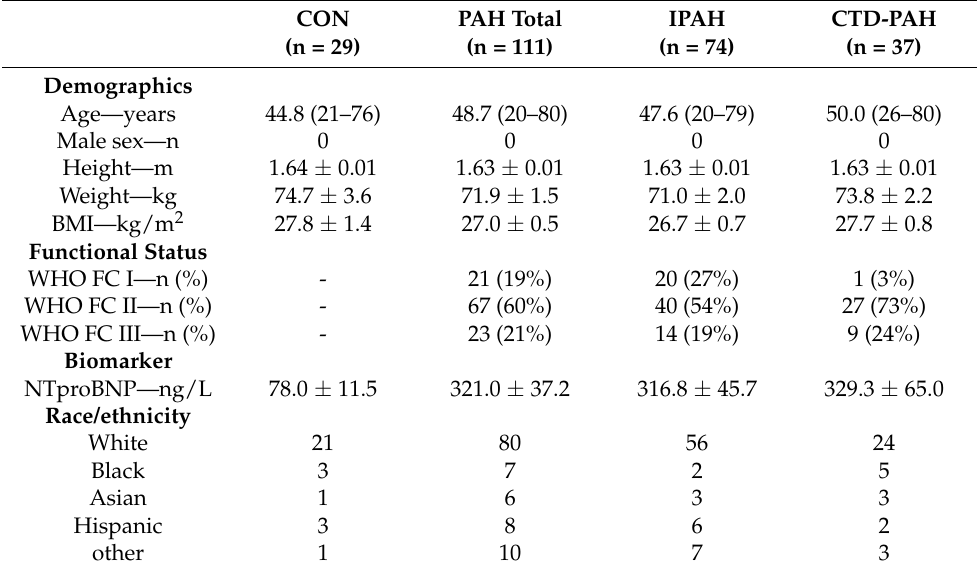
Table 1. Characteristics of PAH patients and healthy